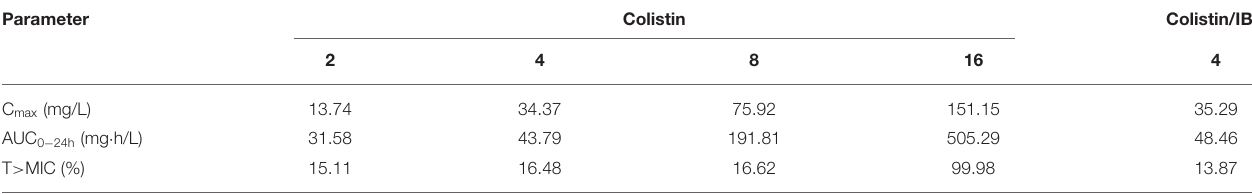
TABLE 2 | Pharmacokinetic parameters of intestinal colistin concentrations following single gavage (2–16 mg/kg) in Salmonella infected broiler. Parameter